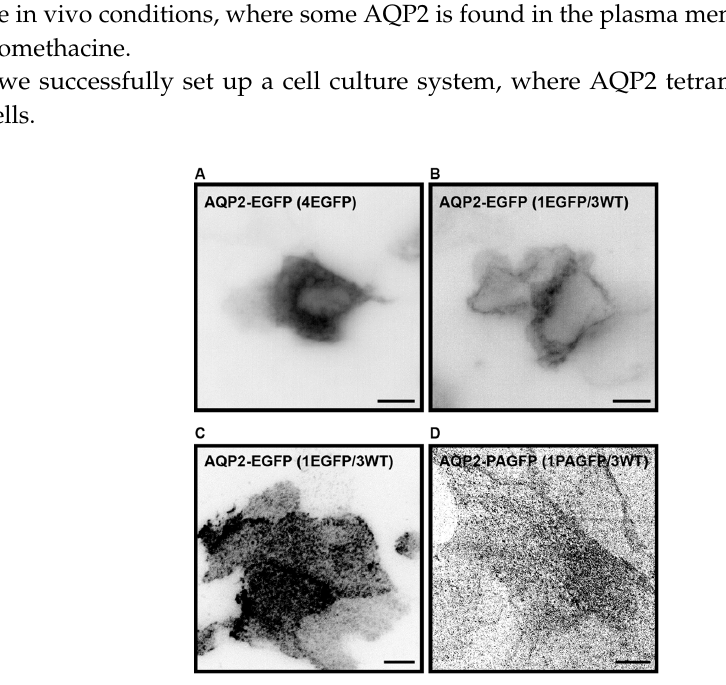
Figure 2. AQP2 plasma membrane localization is rescued by co-transfection of AQP2-EGFP (enhanced green fluorescent protein) and untagged AQP2. ( A , B ) Representative fluorescence images of average projections of a Z-stack of MDCK cells transiently transfected with AQP2-EGFP ( A ) and a mixture of AQP2-EGFP and untagged AQP2 in the ratio 1:3 ( B ), hereafter named AQP2-wild type